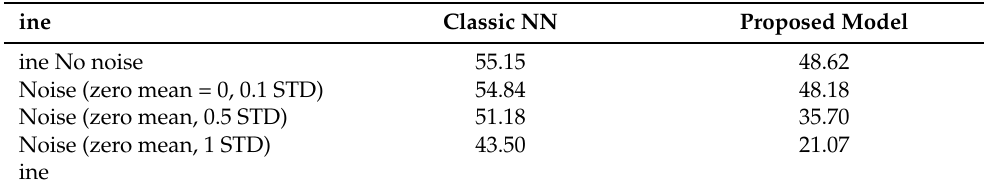
Table 5. Generalization accuracy (%) on holdout test sets for